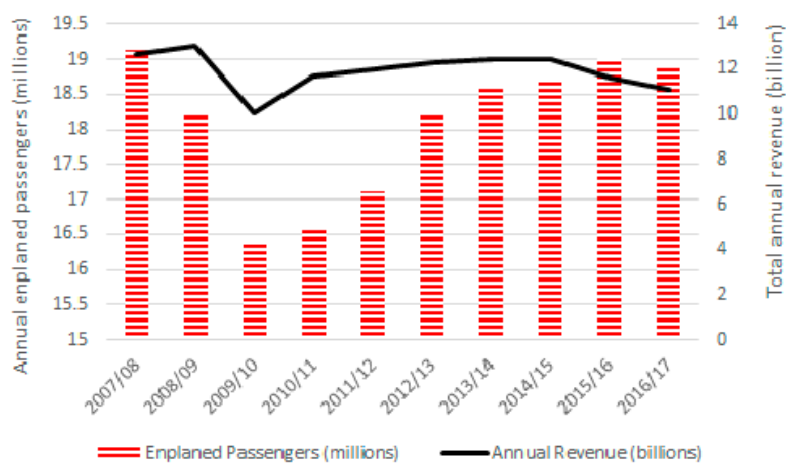
Figure 1. Singapore Airlines total annual enplaned passengers and annual total revenues: 2007/08– Figure 2016/17. Source: data derived from [77].